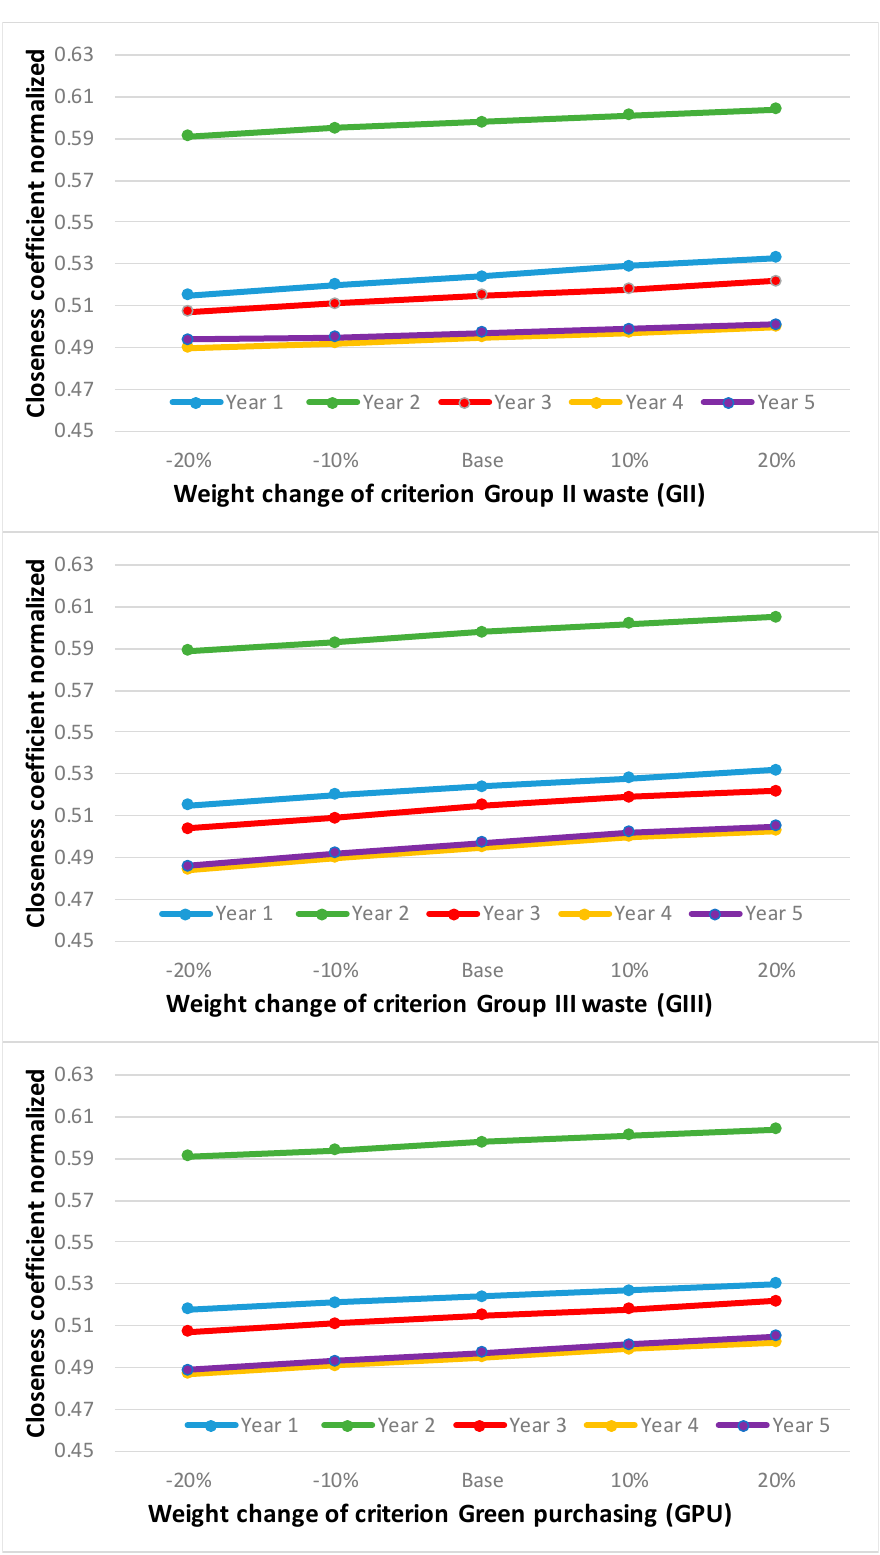
Figure A2. Sensitivity analysis results modifying the patient group weights.